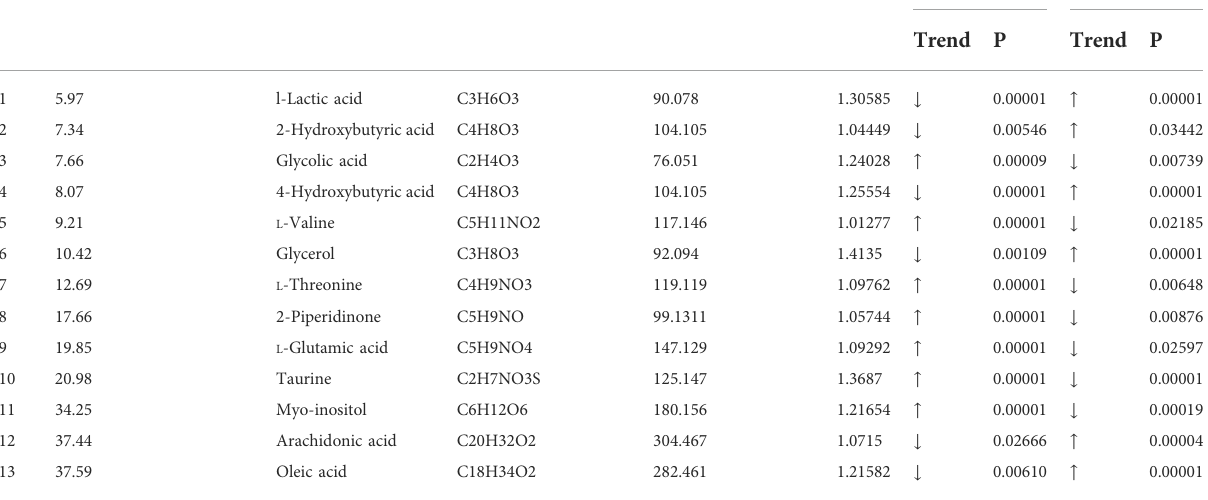
TABLE 2 Differential